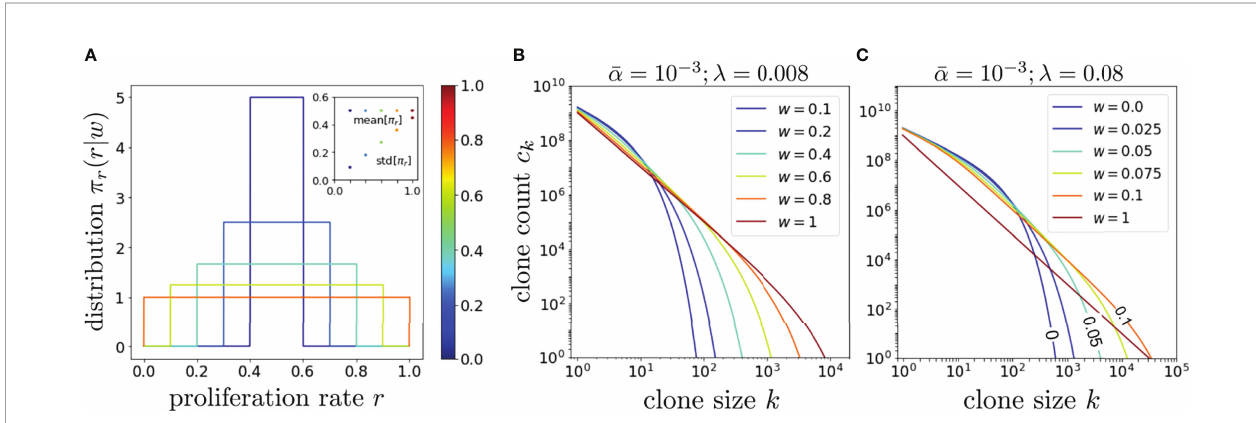
FIGURE 4 | An exploration of the effects of proliferation rate heterogeneity on the mean clone counts c k with Q = 10 13 . (A) Various box distributions p r ( r | w ) for w = 0, 0.2, 0.4, 0.6, 0.8, and 1. (B) Using Eq. 14 and the dimensionless values (cid:2) a = 10 − 3 , l = 8 (cid:4) 10 − 3 such that l = (cid:2) a = 8, we plot, using the same color spectrum as (A) , the corresponding clone counts C k and show that wider distributions typically generate longer-tailed c k . However, if l is set even larger such that l = (cid:2) a = 80 even modest values of w can generate a very long-tailed c k , as shown in (C) . The color spectrum in (C) is for visualization only and not associated with that in (A, B) . In the limit of very large l = (cid:2) a , the effects of heterogeneous proliferation saturate at very small w beyond which it has negligible effect in further extending the